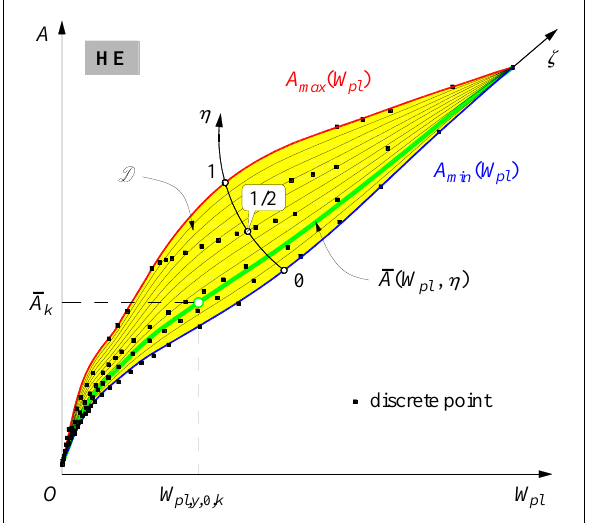
Fig. 8. Isocurves’ field of HE profile